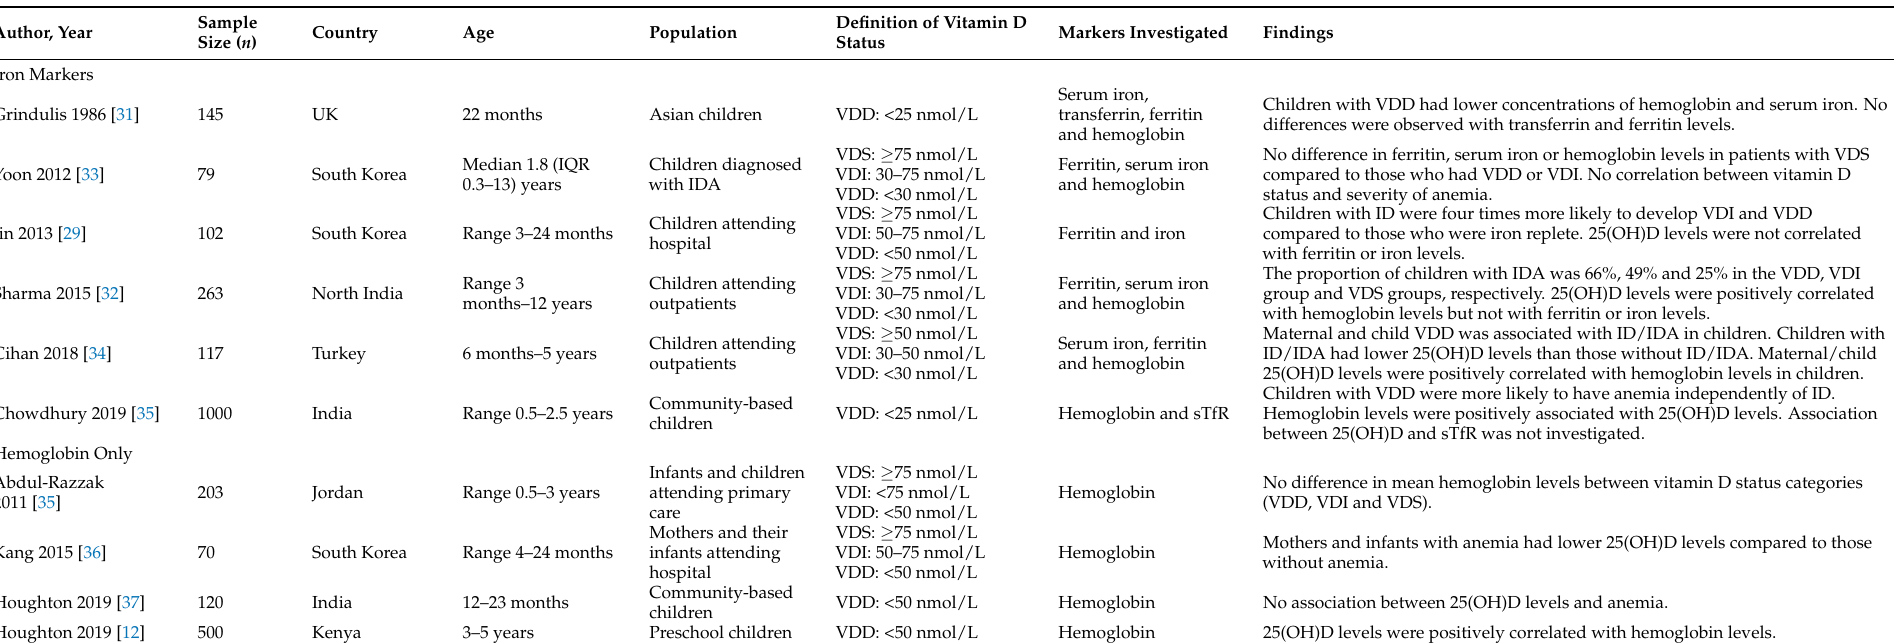
Table 2. Summary of previous observational studies that evaluated the association between vitamin D status and markers of iron status and hemoglobin levels in children (<13 years